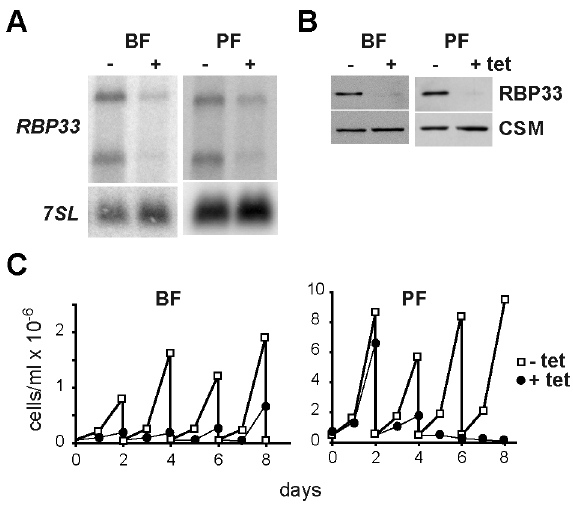
Figure 2. RBP33 is an essential protein in trypanosomes. Cell lines were generated that expressed RBP33 -specific dsRNA in a tetracycline-inducible manner. The levels of mRNA (A) or protein (B) were analyzed in cells incubated with tetracycline for 48 h. Loading controls were the 7SL RNA [40] or the CSM protein [39]. (C) RNAi cell lines were grown in the absence (open squares) or presence (filled circles) of 1 m g/ml tetracycline to induce RNAi. Cultures were followed up to 8 days and diluted to 0.5 6 10 5 cells/ml (bloodstream) or 0.4 6 10 6 cells/ml (procyclic) every 2 days as required.